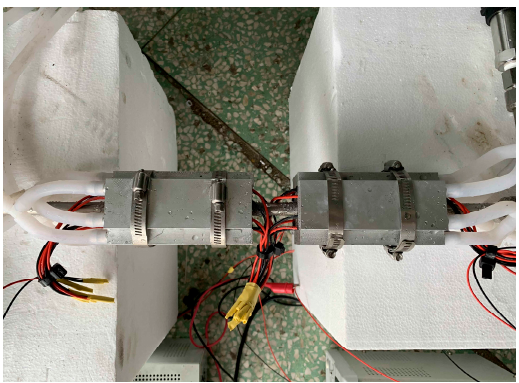
Figure 18. The thermoelectrical refrigeration device connected into hydraulic pipe.